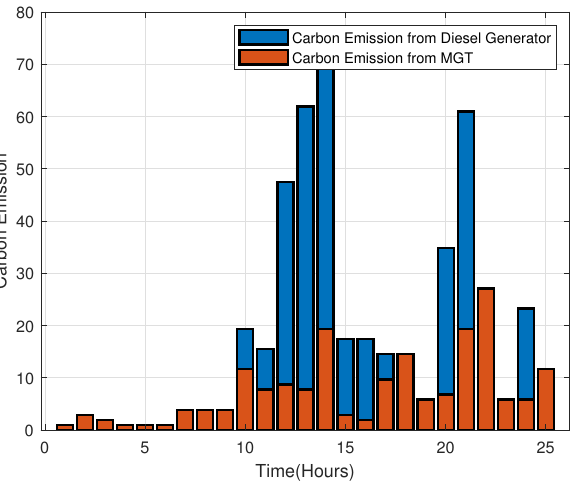
Figure 16. Carbon emission reduction using MGT/diesel generator with microgrid as a backup source.